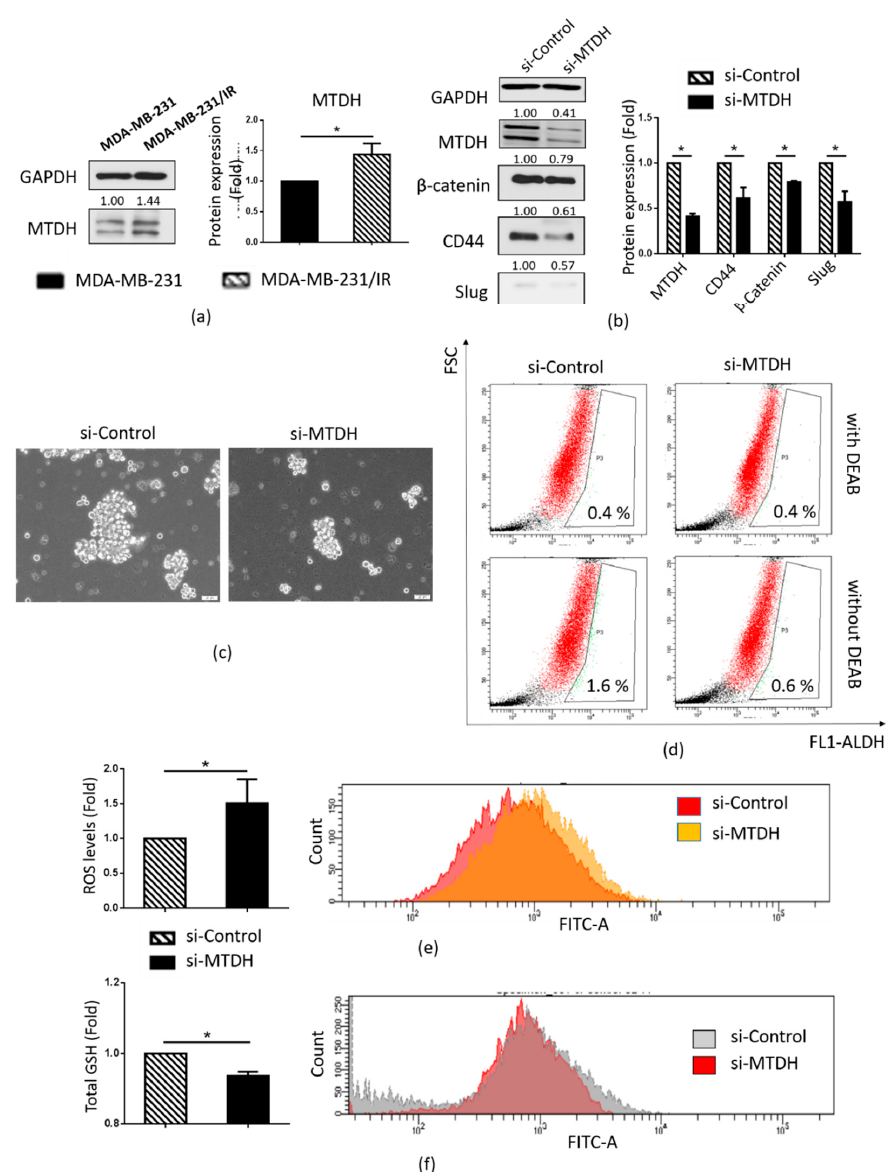
Figure 4. Role of MTDH in regulating the CSC population in MDA-MB-231 / IR cells. ( a ) Western blot analysis of MTDH in MDA-MB-231 and MDA-MB-231 / IR cells. ( b ) Western blot analysis of MTDH, β -catenin, CD44, and Slug after knockdown by si-MTDH for 48 h. ( c ) Appearance of mammospheres after siRNA knockdown (100 × magnification). ( d ) ALDH + population obtained by the ALDEFLUOR assay kit, with DEAB used as a negative control. ( e ) ROS levels measured by FACS analysis and H 2 DCFDA staining. ( f ) The CD44 + population, as assessed by FACS analysis; * p < 0.05; results are presented as mean ± standard